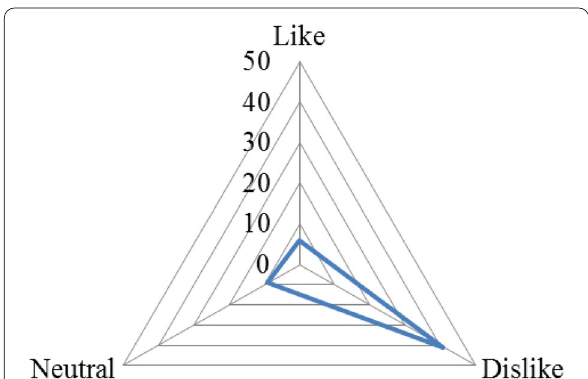
Fig. 7 Attitude towards snow leopard